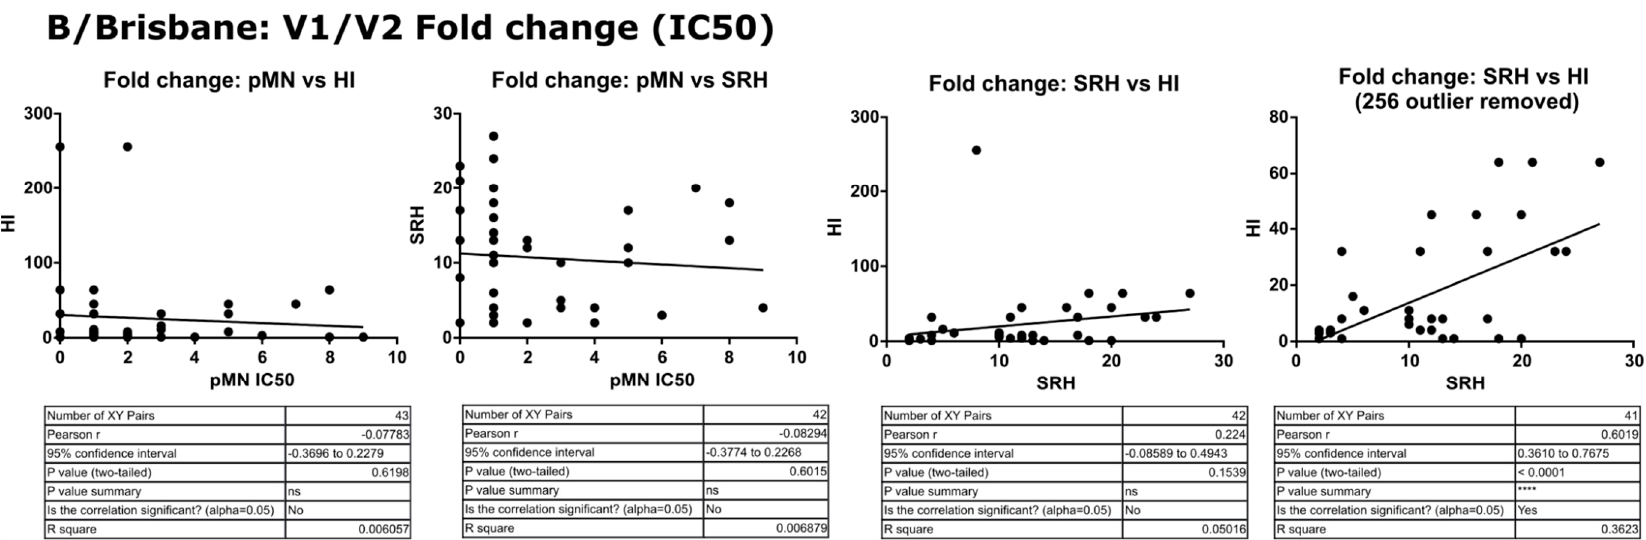
Figure 7. Correlation of SRH, HI and pMN (IC 50 ) V1 to V2 fold-change values assayed against B/Brisbane/60/2008 PV. Pearson’s two-tailed analysis performed using GraphPad Prism. No correlation was observed between IC 50 antibody titres and HI or SRH (Pearsons r = − 0.07 and − 0.08, respectively). Weak correlation was observed between SRH and HI (Pearsons r = 0.22), which was improved after removal of outlying HI value (Pearsons r = 0.60). p > 0.05 = ns, p ≤ 0.0001 = ****.